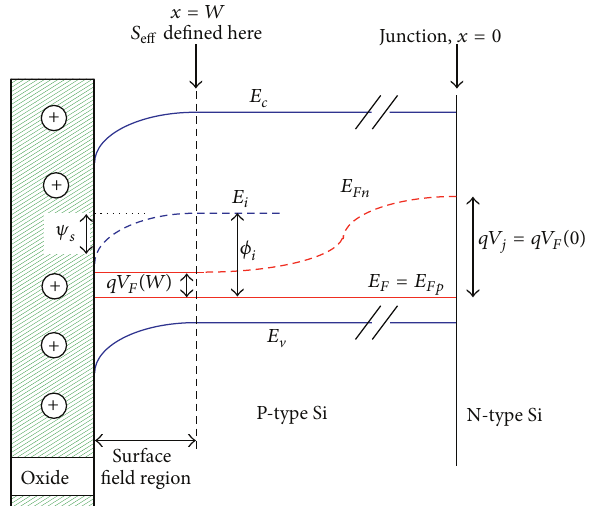
Figure 1: Band diagram at a p-type back surface showing band bending, surface potential, and surface field (space charge)